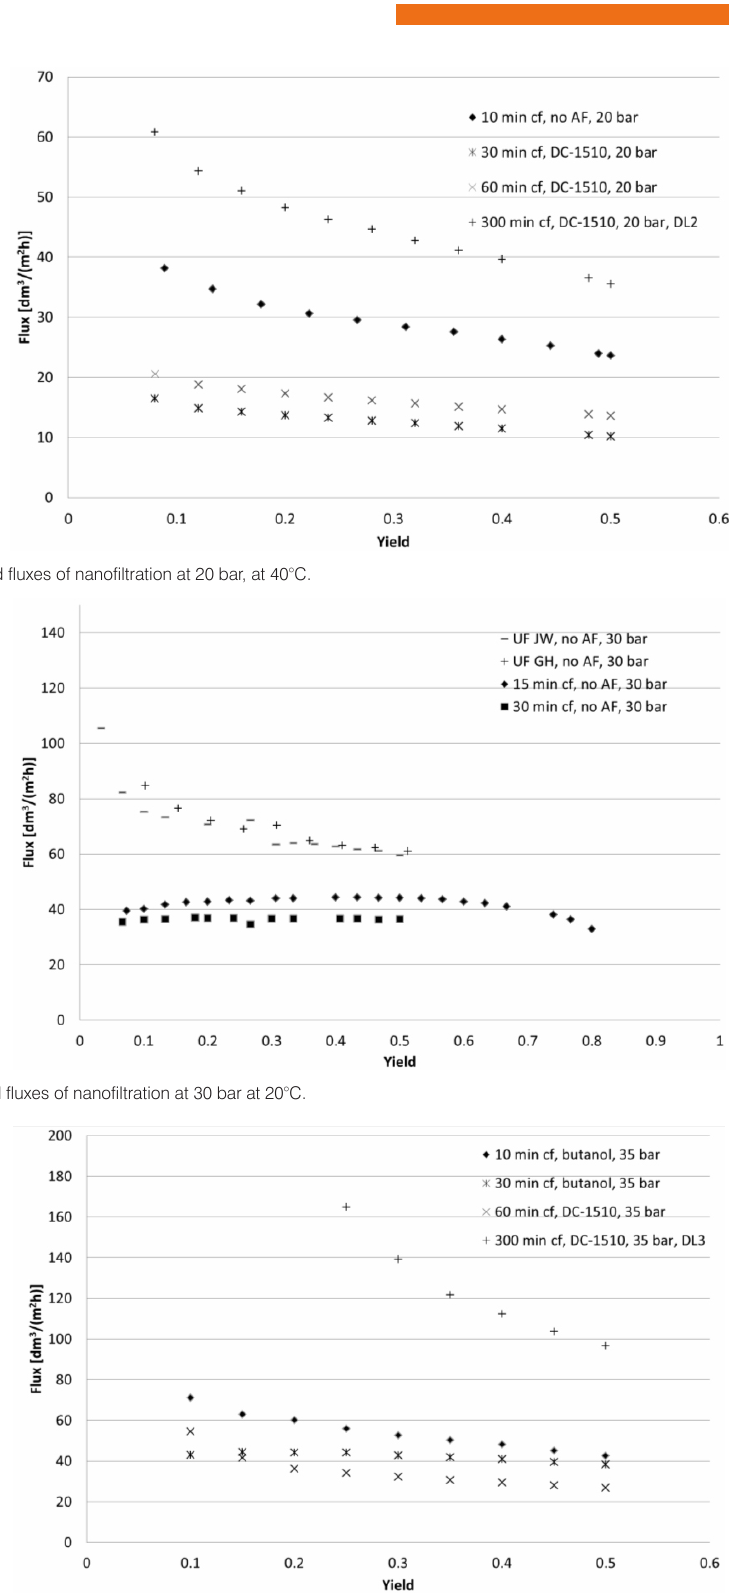
Figure 9. Measured fluxes of nanofiltration at 35 bar, at